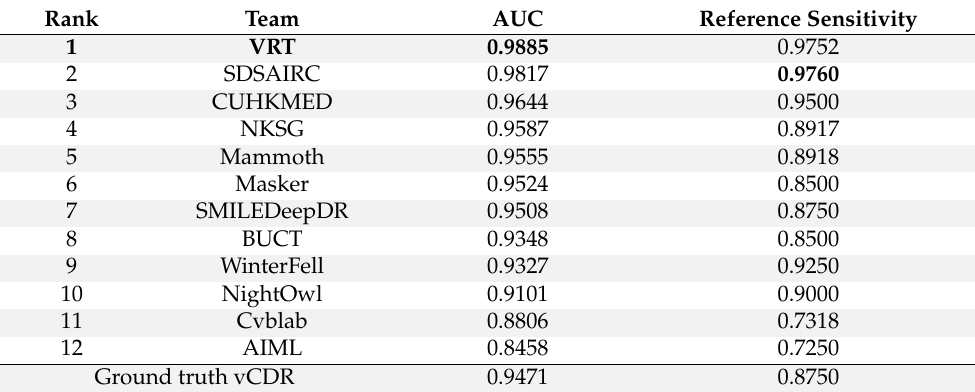
Table 11. Ranking results of the participating teams in the REFUGE test set. The last row corresponds to the results obtained using the